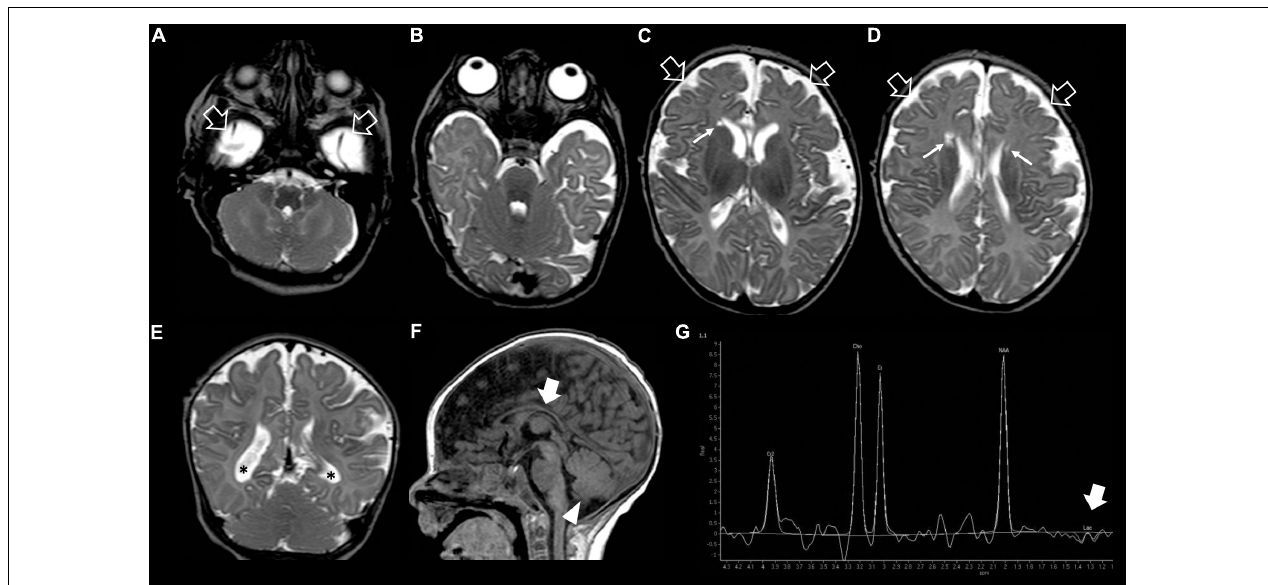
FIGURE 2 | Brain MRI and MR spectroscopy at 4 months of age. (A–D) Axial and (E) Coronal T2-weighted images reveal delayed myelination, bilateral frontal periventricular cysts (arrows), enlarged subarachnoid spaces especially in the frontal-temporal regions (empty arrows), reduced white matter volume with mild lateral ventricle dilatation (asterisks). (F) Sagittal T1-weighted image shows hypoplasia of the corpus callosum (thick arrow) and inferior cerebellar vermis (arrowhead). (G) Brain MR spectroscopy performed at the level of the right basal ganglia demonstrates small lactate peaks (thick